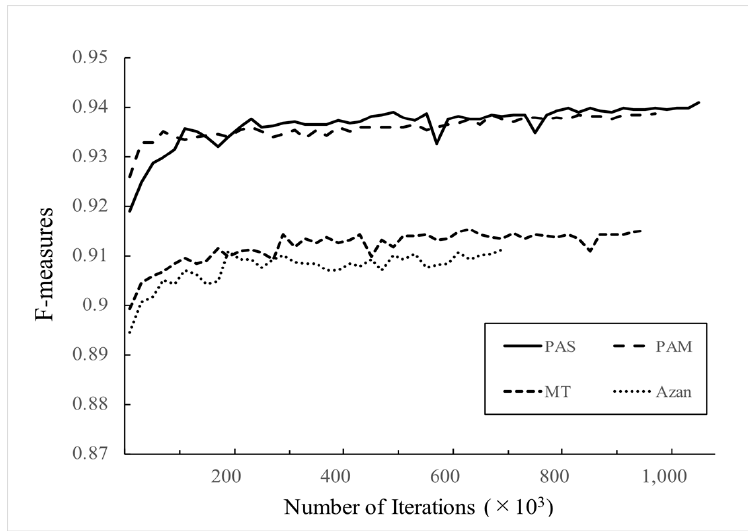
Figure A1. Training curves for the validation set of different stains. The vertical axis shows average of F-measures by fivefold cross-validation and the horizontal axis shows number of iterations for training the networks. The trainings were stopped at 1,060,000 iterations in PAS, 980,000 iterations in PAM, 960,000 iterations in MT, and 680,000 iterations in Azan, respectively.